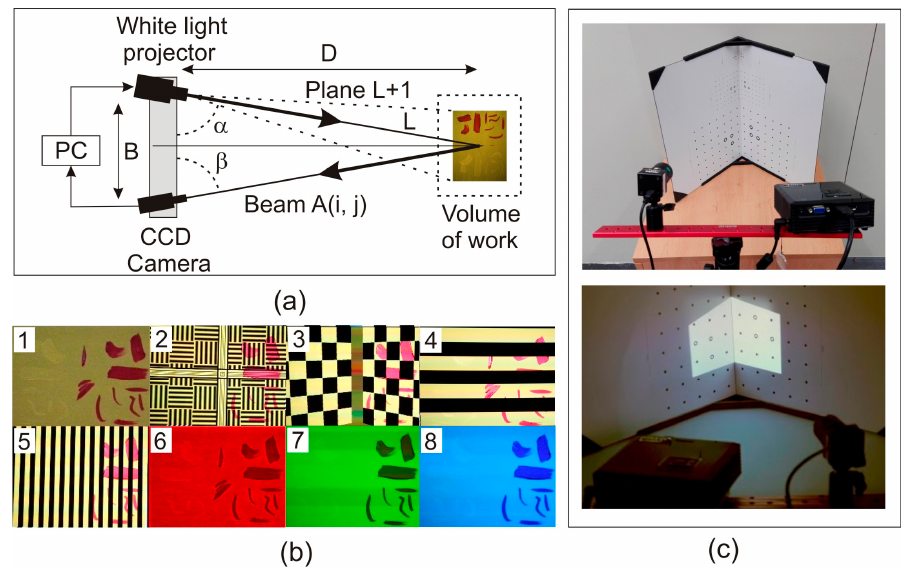
Figure 2. ( a ) Schematic explanation of the photogrammetric method used; ( b ) Capture images of the